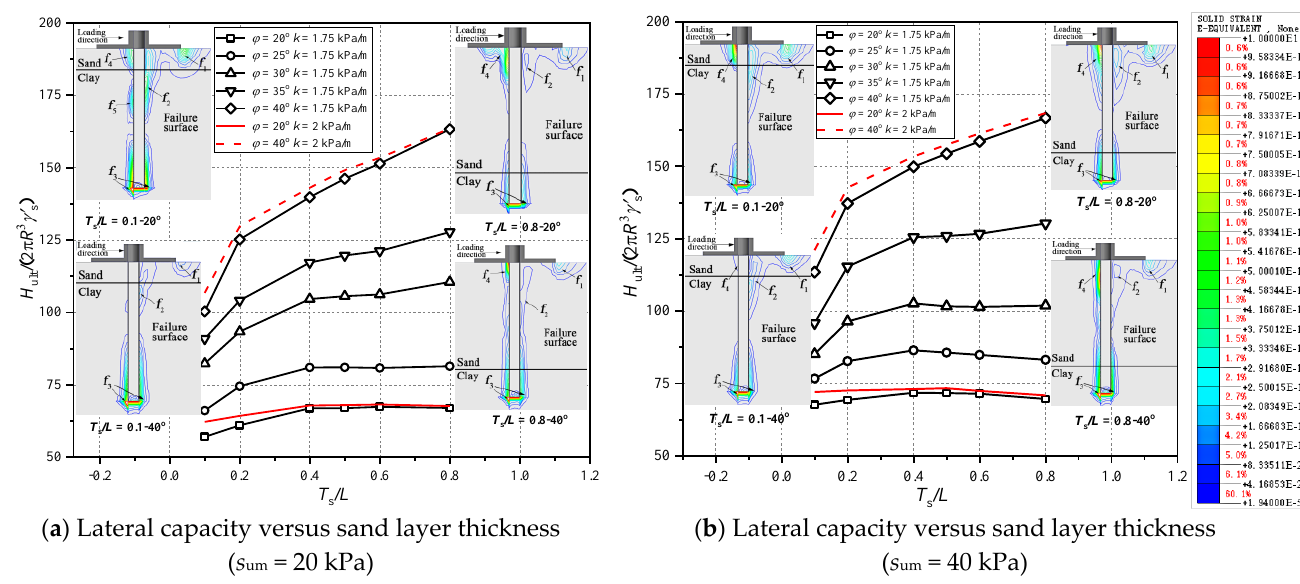
Figure 6. Effect of wheel diameter on the lateral capacity and the failure mechanism. Figure 7 demonstrates the lateral earth pressure distributions along the right side of the pile body under different T s / L and ϕ by plotting normalized lateral earth pressure P p /(2 π R γ ′ s ) versus depth below the mudline z / D p . In terms of T s / L = 0.1, there are no obvious differences between the earth pressure distributions when ϕ = 20° and 40°, with the same depth of maximum earth pressure z max = 0.4 L , which is in accordance with the case when the composite foundation is in pure clay [32]. Besides that, no abrupt change is captured at T s / L = 0.1, and it indicates that the bearing capacity is mainly controlled by the combined wheel rather than the soil resistance provided by the pile. For T s / L = 0.4, the overall earth pressure distribution is significantly different from that of T s / L = 0.1, with its z max elevate to above 0.3 L . Apparently, a sharp decrease of soil resistance can be found at T s / L = 0.4 as the depth descends. In addition, the depth of the maximum earth pressure raises with larger ϕ ( ϕ = 20°: z max /L = 0.28; ϕ = 40°: z max / L = 0.19). As T s / L increases from 0.4 to 0.8, for ϕ = 20°, the earth pressure along pile barely changes, while it experiences an obvious increase within the range of z / L = 0~0.55 when ϕ = 40°, which is consistent with the phenomenon shown in Figure 6.